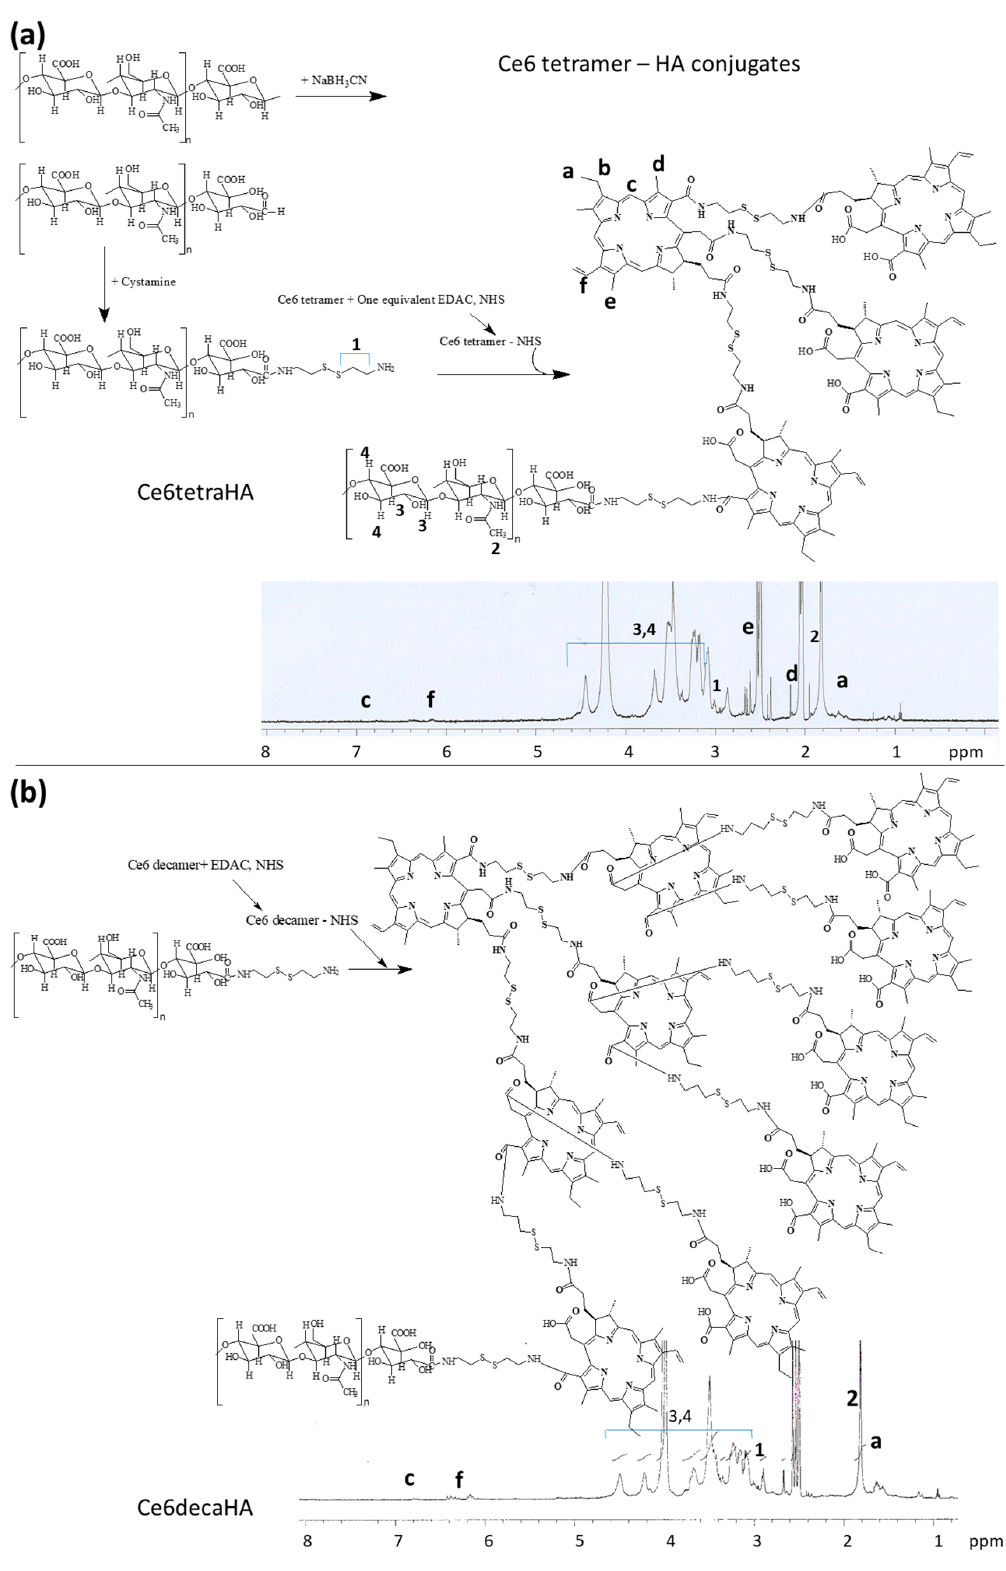
Figure 2. Synthesis and 1 H NMR spectra of ( a ) Ce6tetraHA conjugates and ( b ) Ce6decaHA conjugates. For measurement of 1 H NMR (500 mHz) spectra, Ce6tetraHA and Ce6decaHA conjugates were distributed in 0.2 mL of D 2 O and then mixed with 0.8 mL DMSO-d 6 .